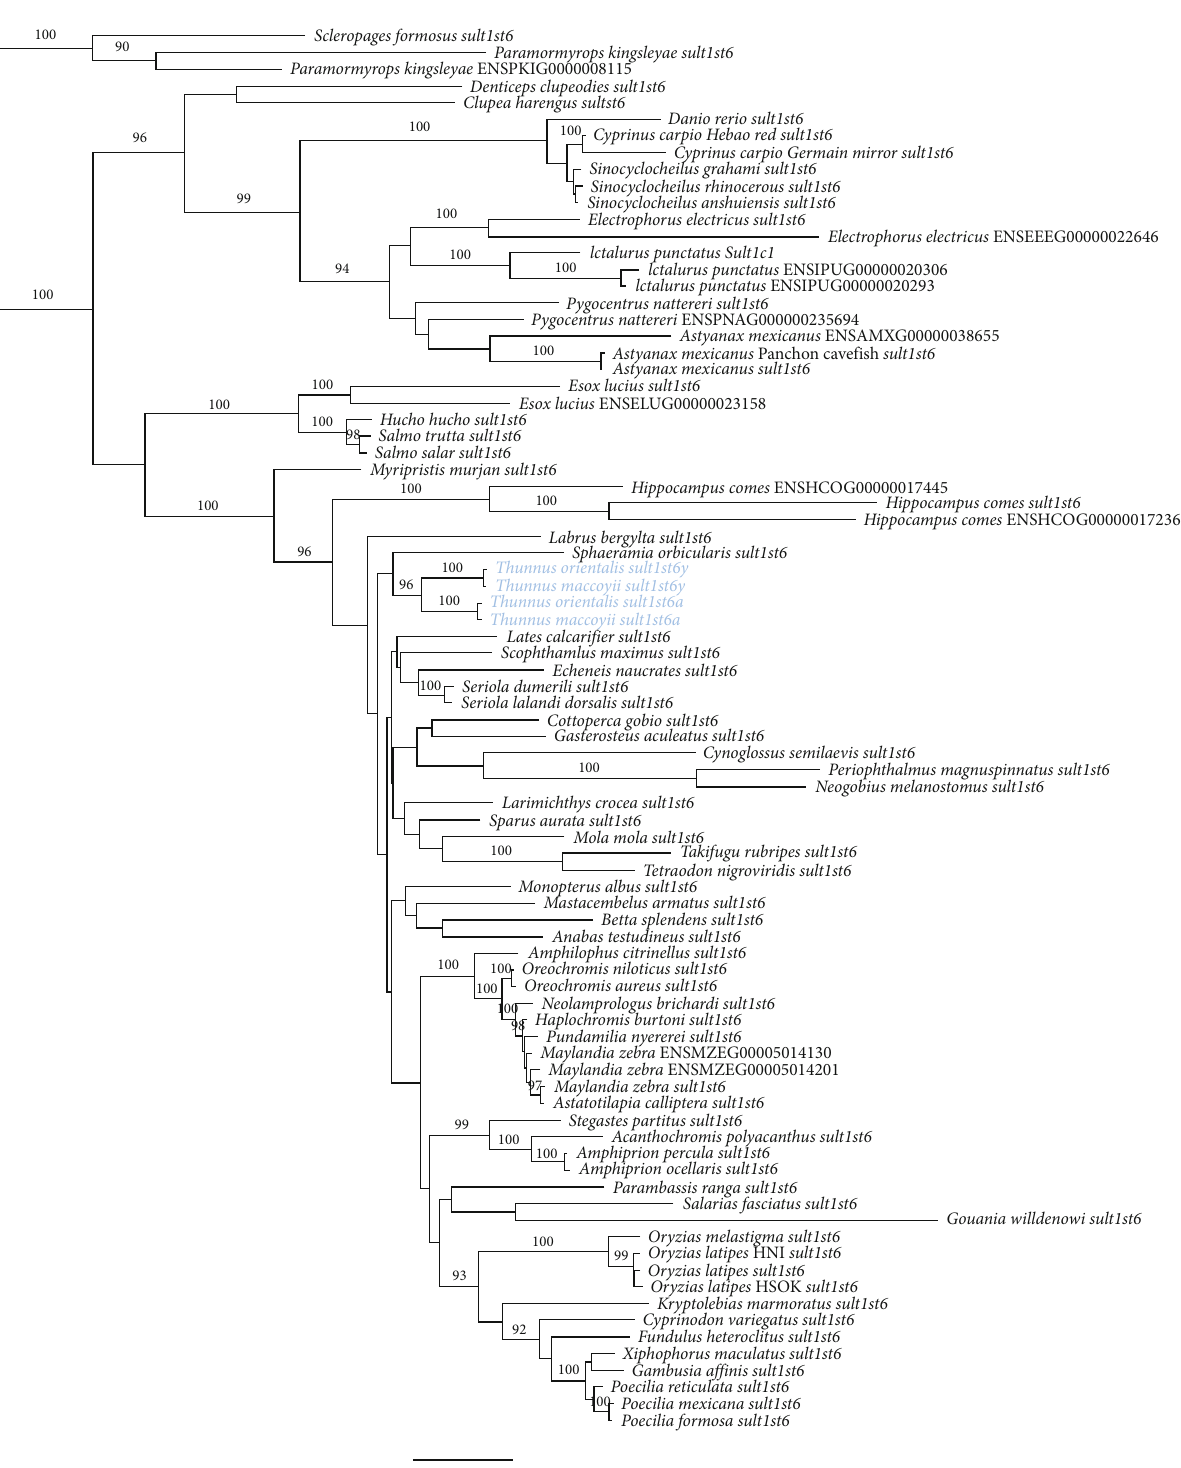
Figure 9: Phylogenetic tree of sult1st6 in fi sh species. For each of the nodes, the bootstrap probability is indicated when it is ≥